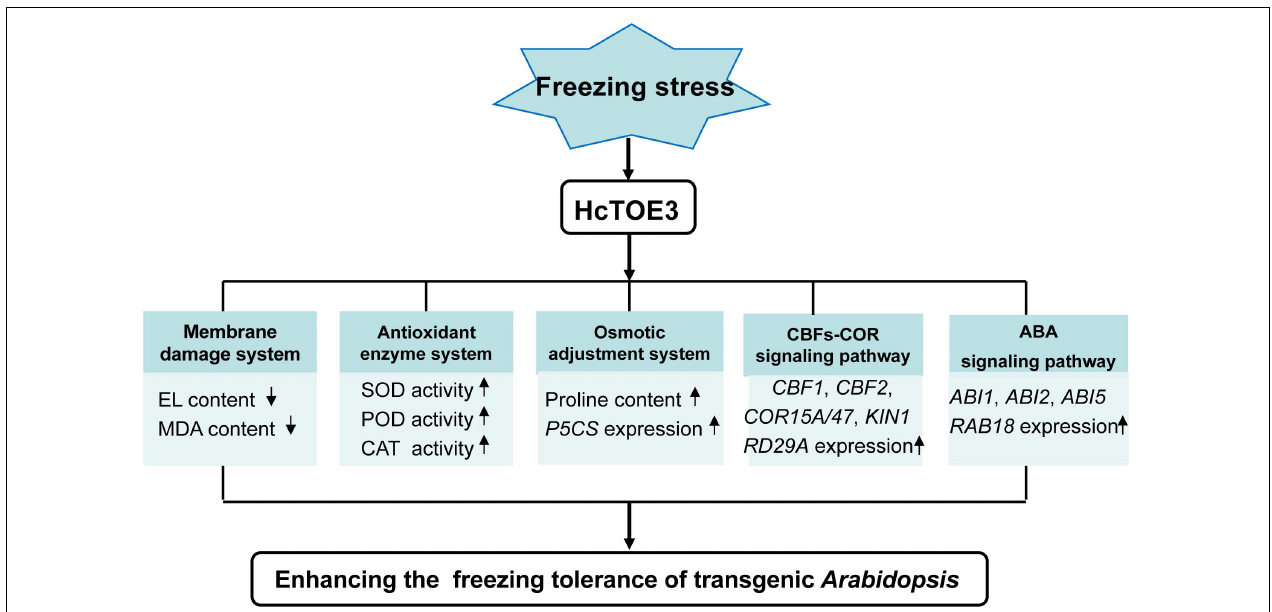
FIGURE 7 | Model of HcTOE3 regulation of the freezing stress response in transgenic Arabidopsis . The model indicated that overexpression of HcTOE3 up-regulates genes taking part in CBFs-COR signaling, ABA signaling, proline biosynthesis, and ROS scavenging. These genes lead to an increase in SOD, POD, CAT activities and proline content; a reduction ROS content and cell membrane peroxidation; and ultimately enhancing the freezing tolerance of Arabidopsis .